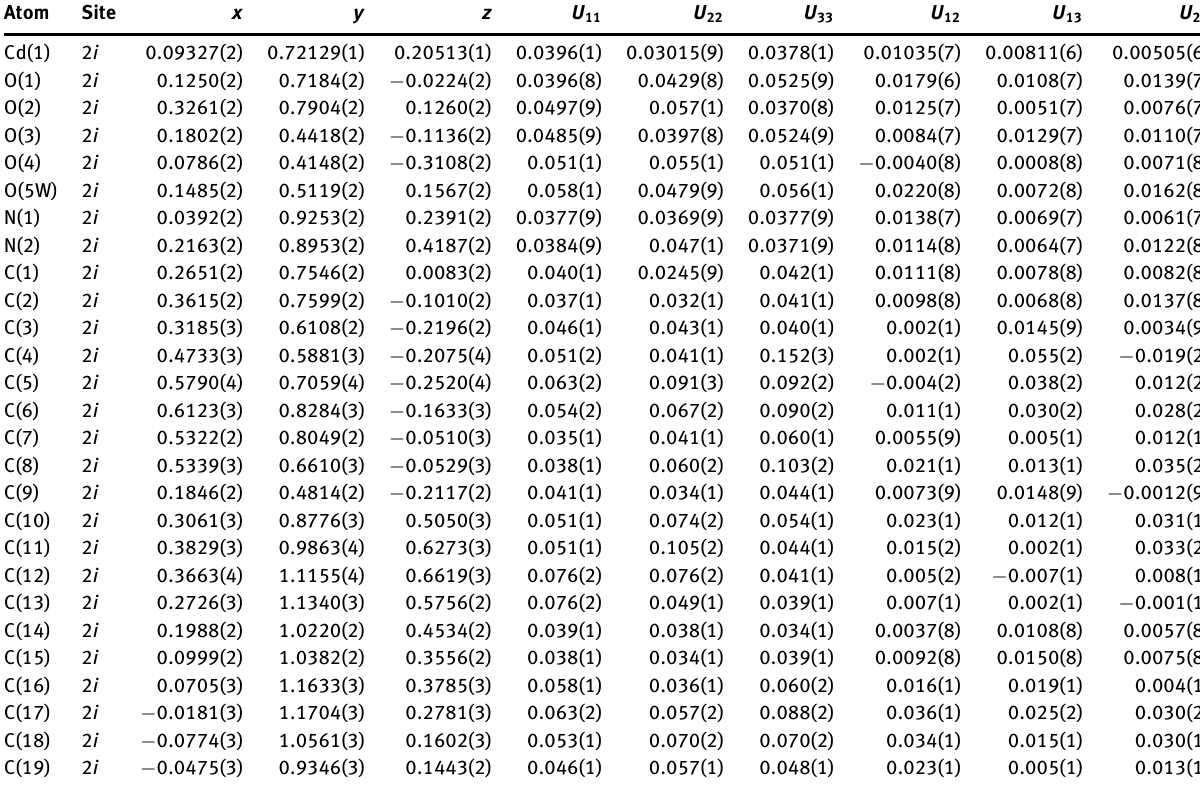
Table 3: Atomic displacement parameters (Å 2